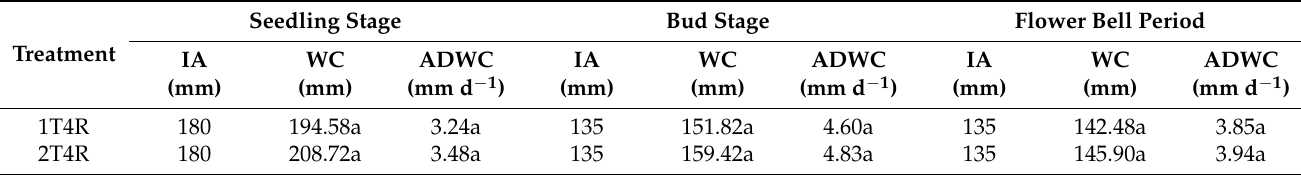
Table 3. Effects of different drip irrigation belt arrangements on cotton water consumption in 2018a.